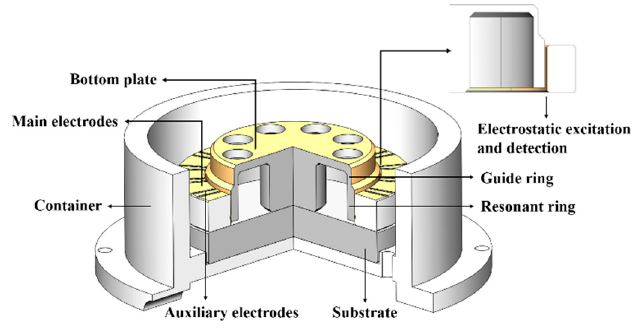
Figure 1. The sectional view of the resonator with electrodes.